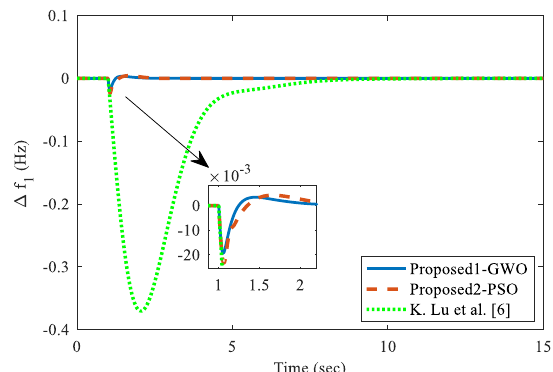
Fig. 13 Frequency regulation in area 1 for case 5b